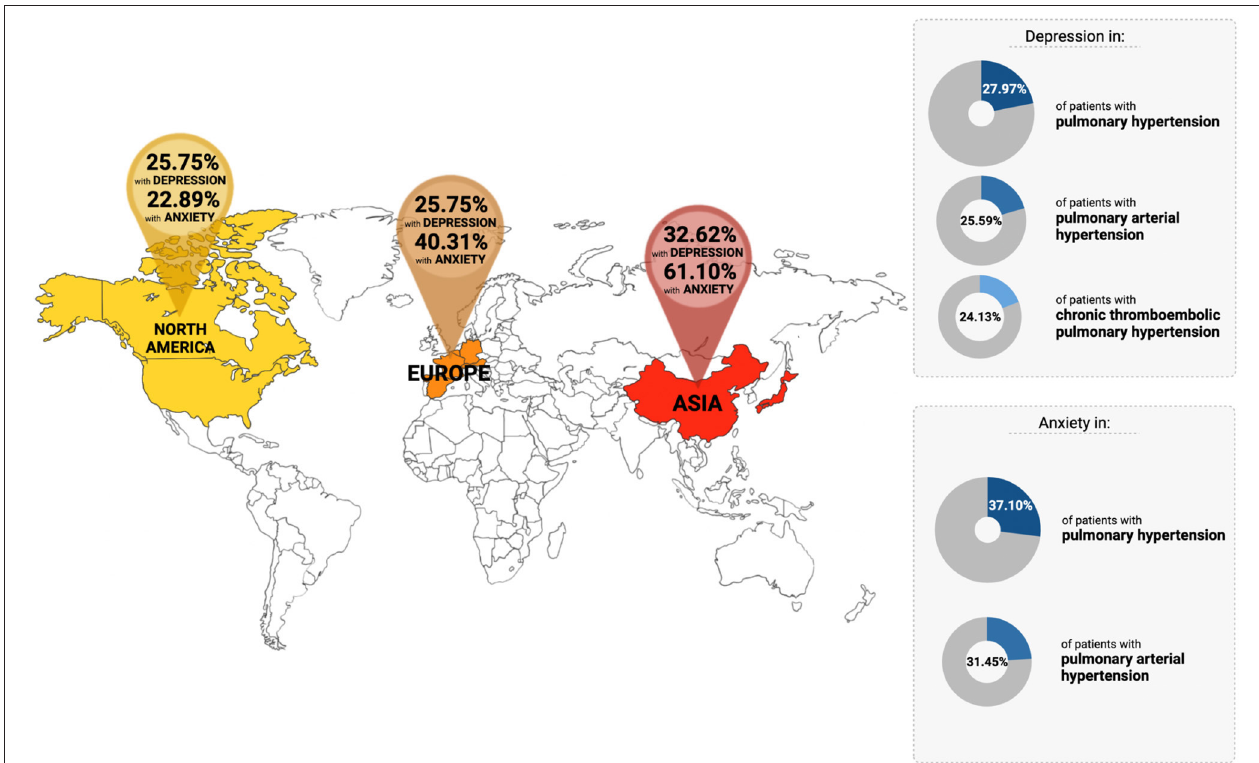
FIGURE 4 | Overview of the prevalence of depression and anxiety in patients with pulmonary hypertension across the